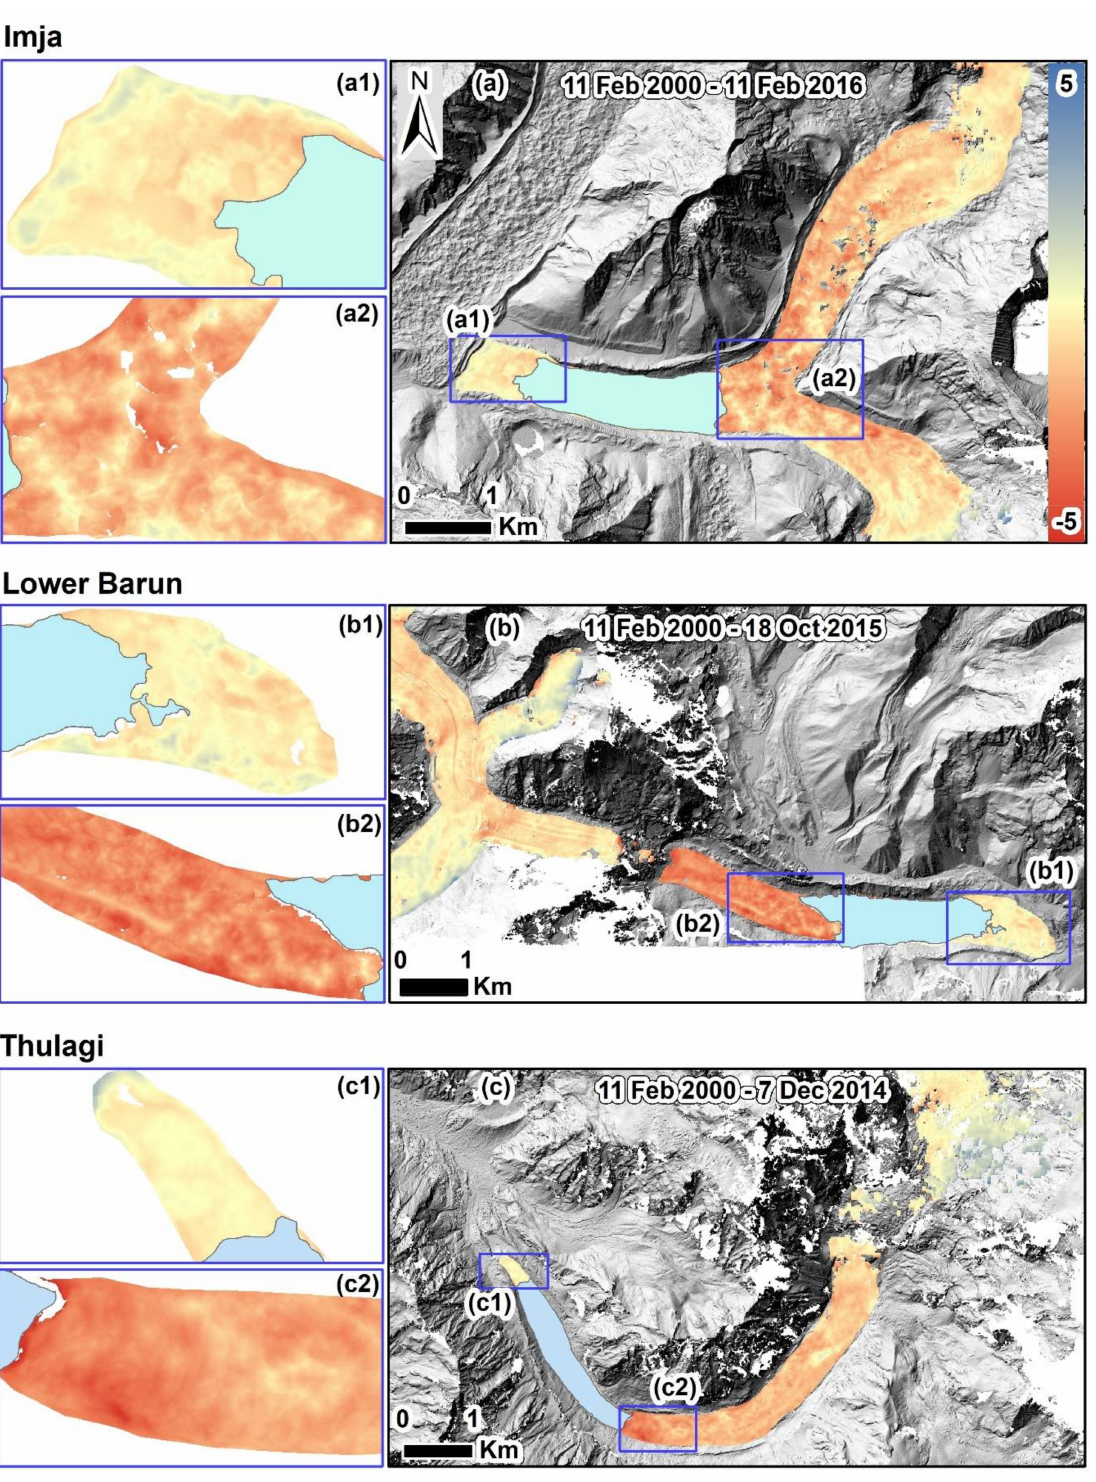
Figure 5. Elevation change rates (m/year) for the three study sites from 2000 to